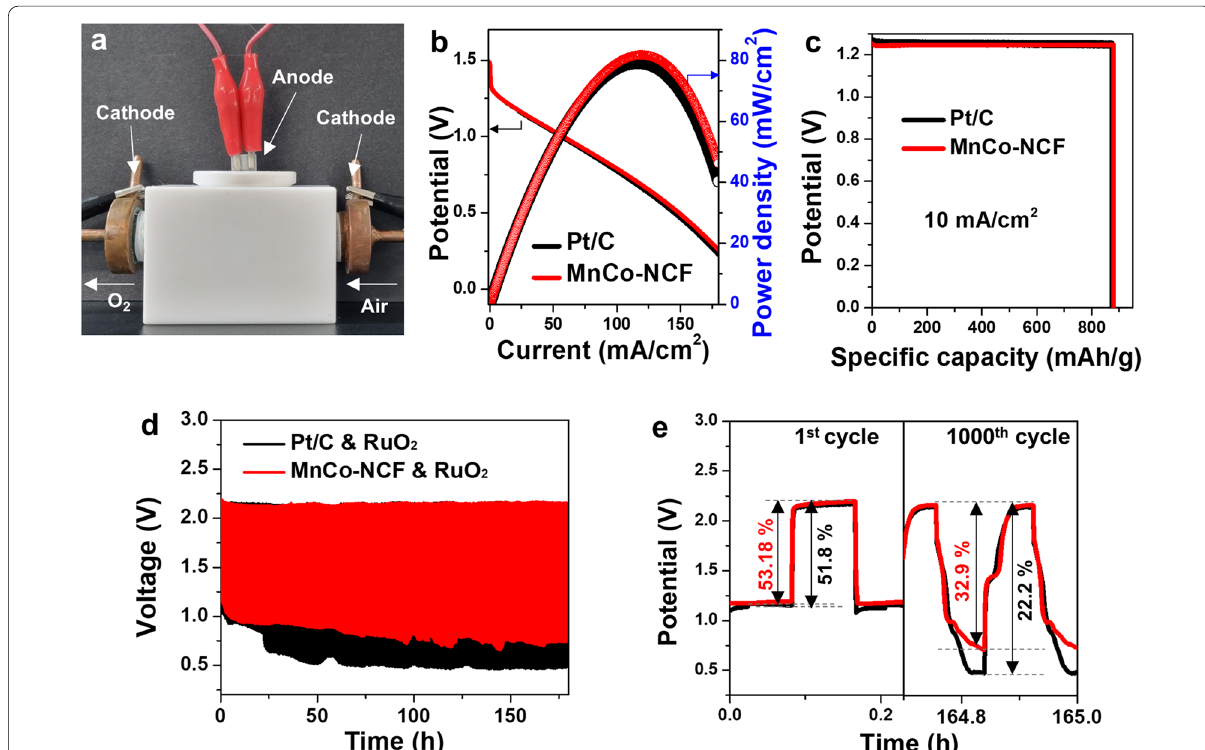
Fig. 5 Performance of a rechargeable Zn–air battery assembled with MnCo‑NCF. a Photograph of the three‑electrode Zn–air battery assembled with MnCo‑NCF and RuO 2 . b Discharge LSV curves and power density plots, c Specific capacity, and d‑e Charge–discharge profiles of the MnCo‑NCF‑catalyzed Zn–air battery and the Pt/C‑catalyzed battery. RuO 2 was employed as a catalyst for charge in both